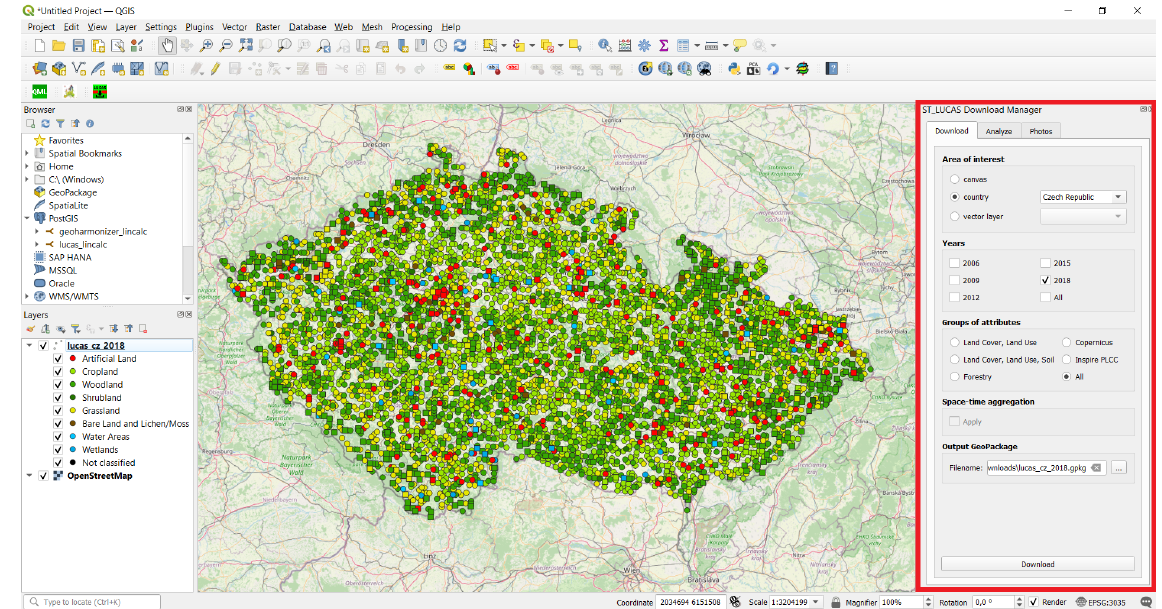
Figure 7. ST_LUCAS QGIS plugin (highlighted by a red box) retrieving harmonized LUCAS data for the Czech Republic territory (background basemap: OpenStreetMap—public WMS view service).